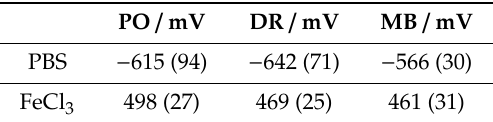
Figure 7. Anodic polarization curves of Ti6Al4V samples. ( a ) Deep-rolled sample tested in PBS, ( b ) deep-rolled sample tested in FeCl 3 , ( c ) microblasted sample tested in PBS and ( d ) polished sample tested in FeCl 3 . Table 3. Corrosion potential (mean (SD)) of polished, deep-rolled and microblasted Ti6Al4V specimens tested in PBS and FeCl 3 -containing electrolyte, respectively.